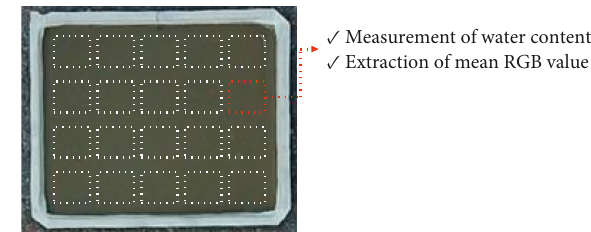
Figure 2: Soil sampling location for water content measurement and RGB value extraction.